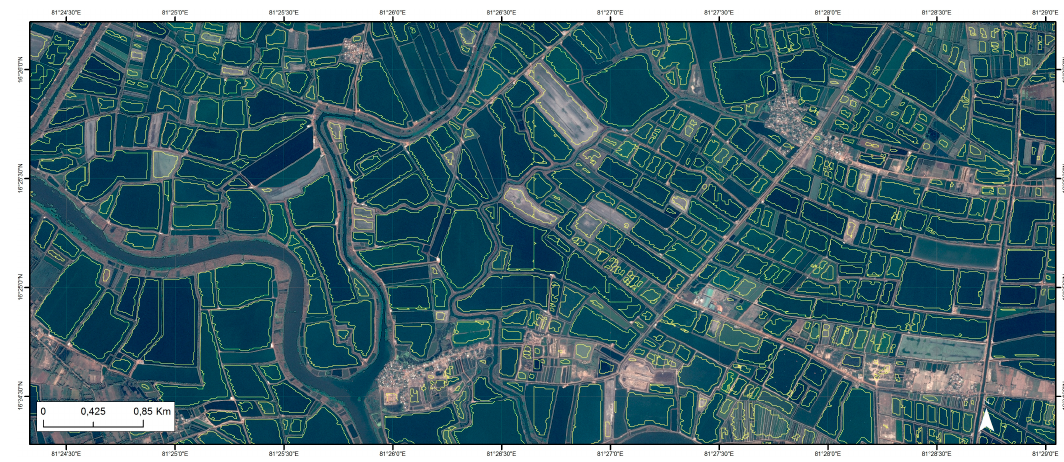
Figure 6. Extracted ponds at local scale compared to real pond structure as observed from very-high-resolution (VHR) Pleiades imagery for a spatial subset in Eluru, Andhra Pradesh.